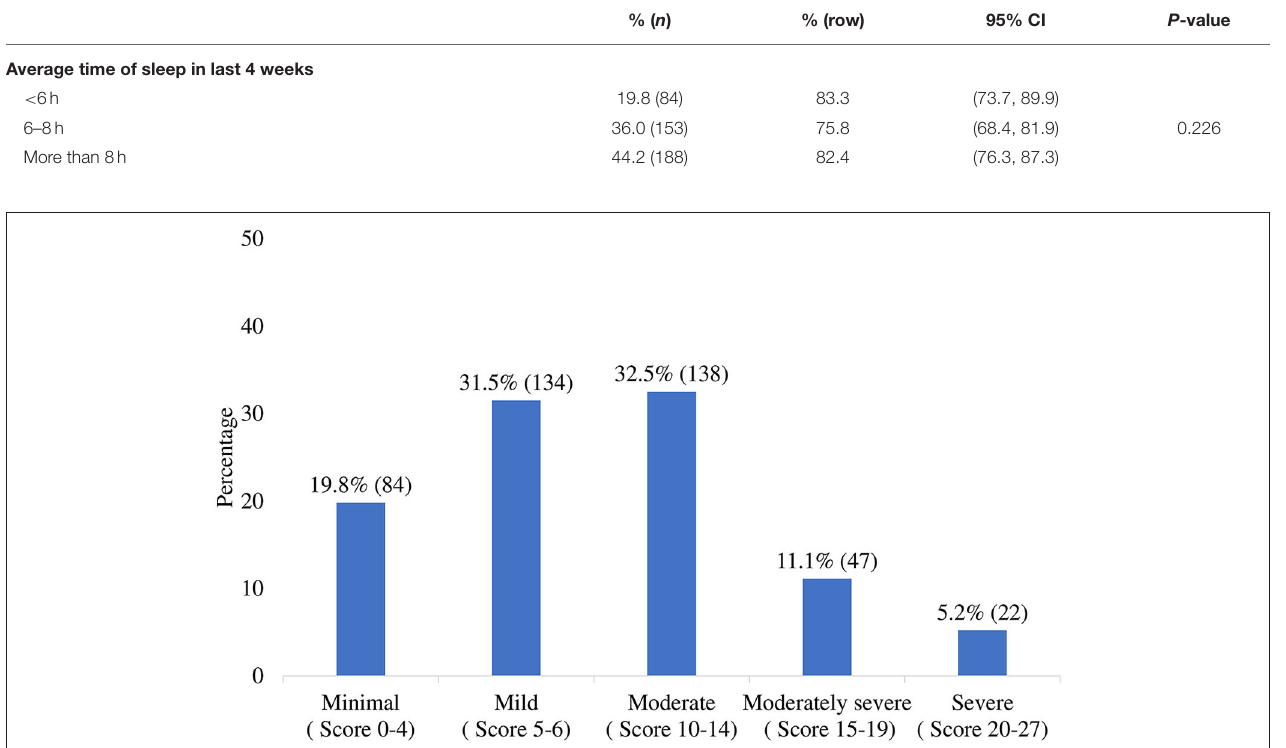
FIGURE 2 | Level of depression severity among medical students obtained by categorizing PHQ-9 score. The total PHQ-9 score was 4,038, with an average 9.5 ± 5.4 and a median 9.0.